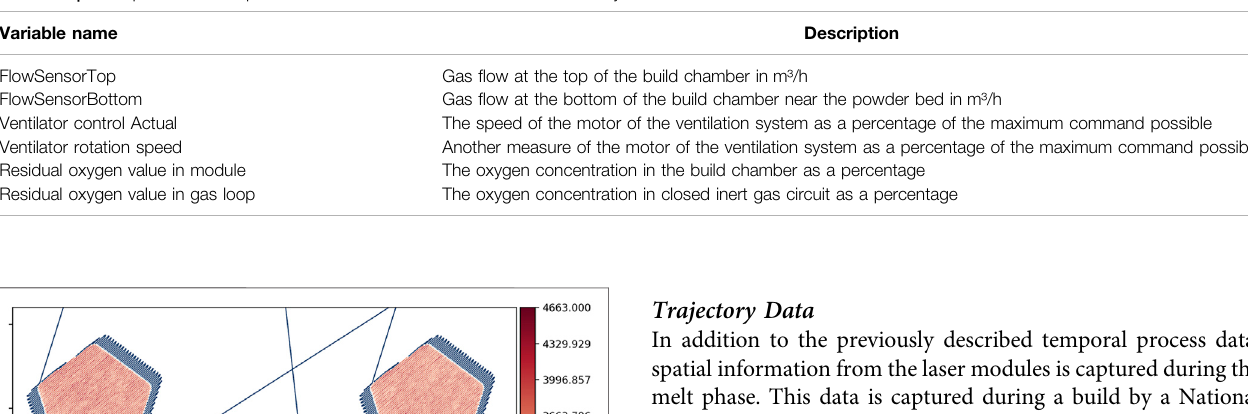
TABLE 1 | Description of in-situ process data used to detect defects for this analysis.